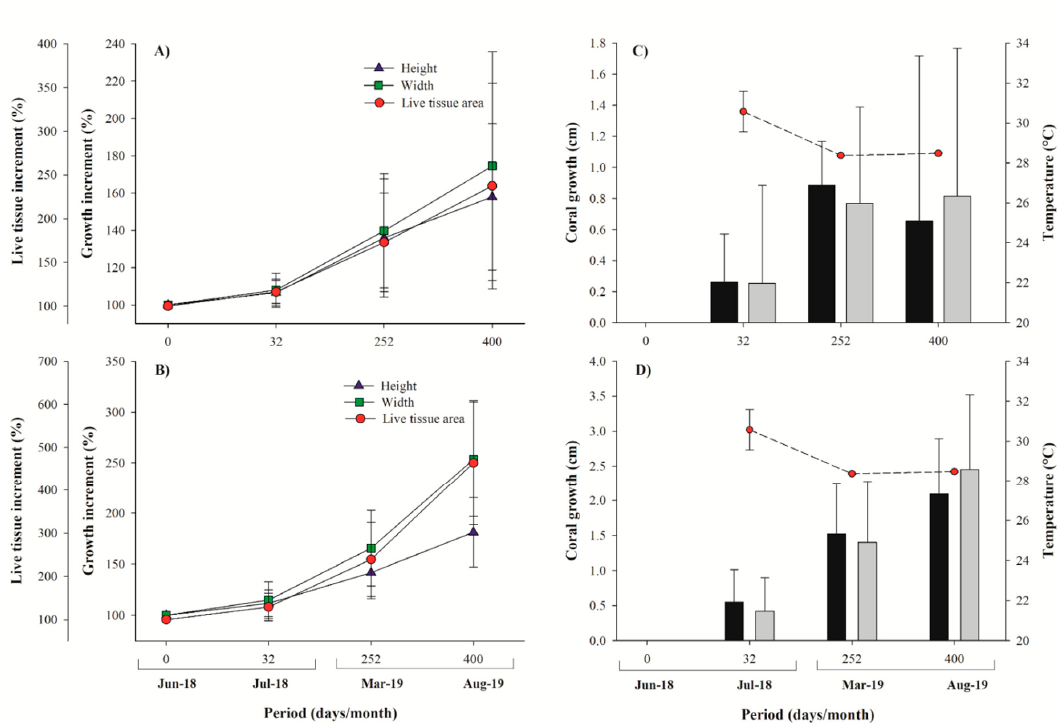
Figure 5. Micro-fragments growth measurements. Percentage of growth increment (% ± SD) of Pavona clavus ( A ) and Pocillopora spp. ( B ). Mean coral growth (cm ± SD) and seawater temperature at each interval time (days) for Pavona clavus ( C ) and Pocillopora spp. ( D ).